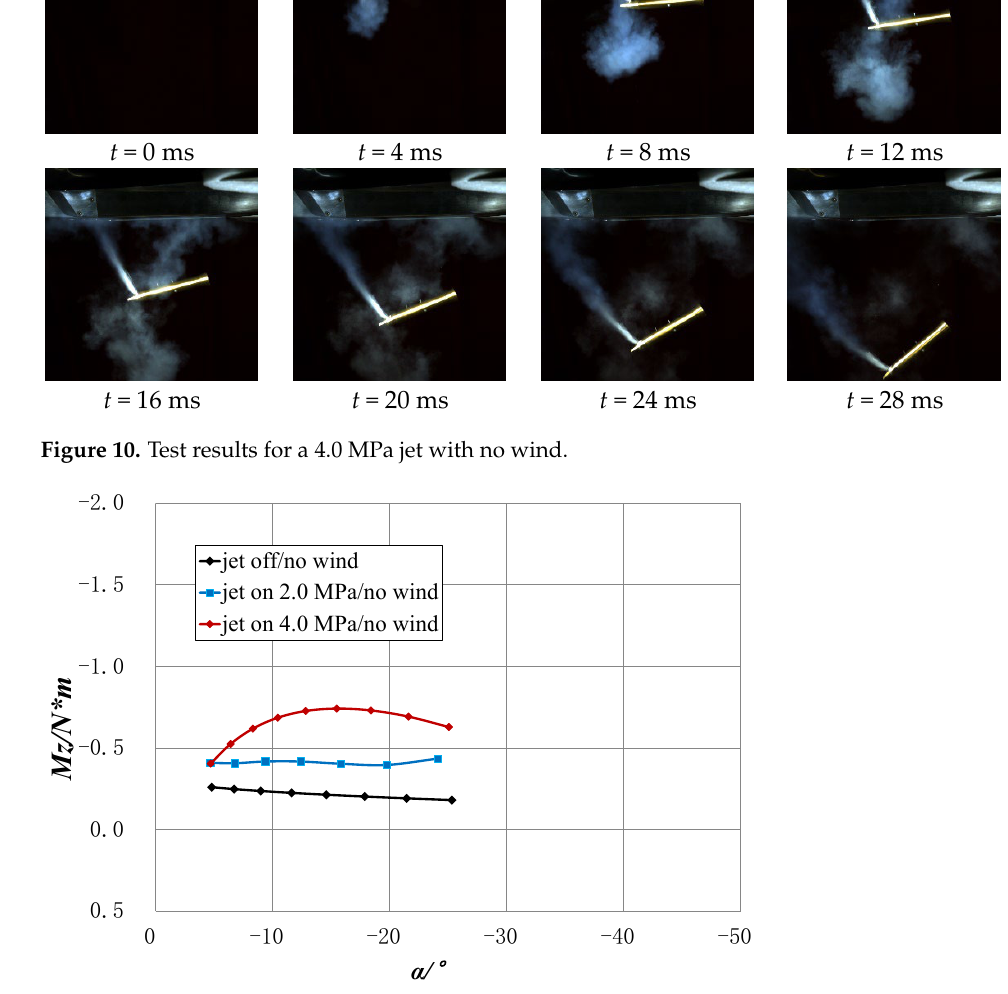
Figure 11. Variation of the revolution body’s pitching moment with the angle of attack for three jet conditions with no wind.